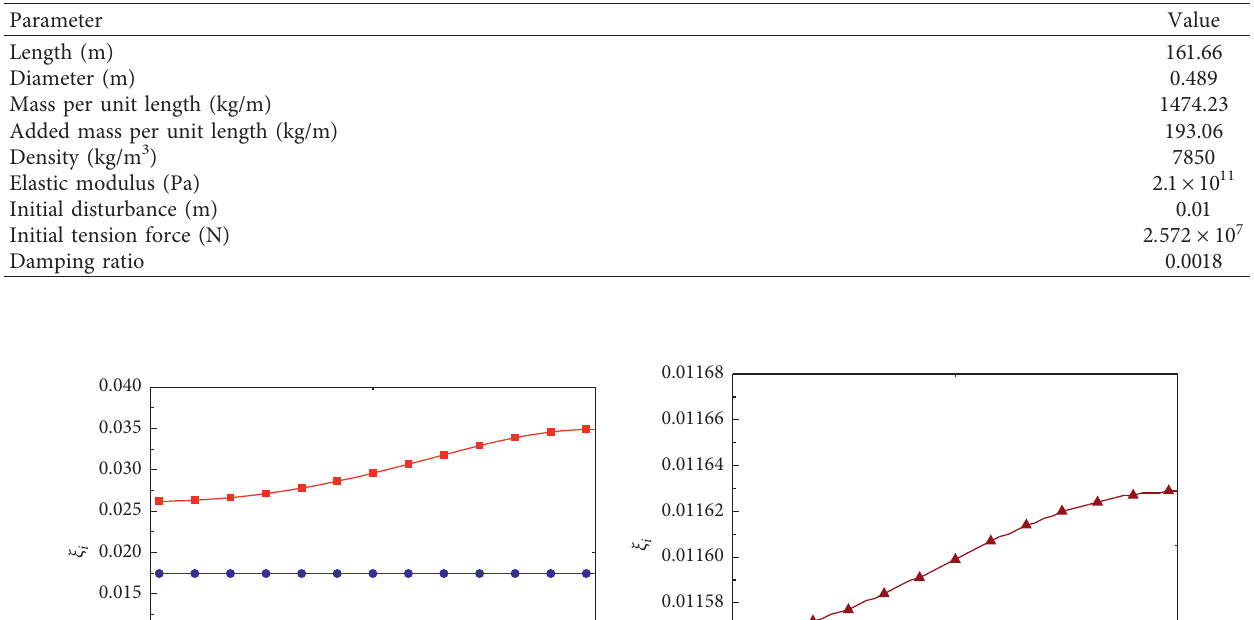
Table 1: Basic parameters of tether.